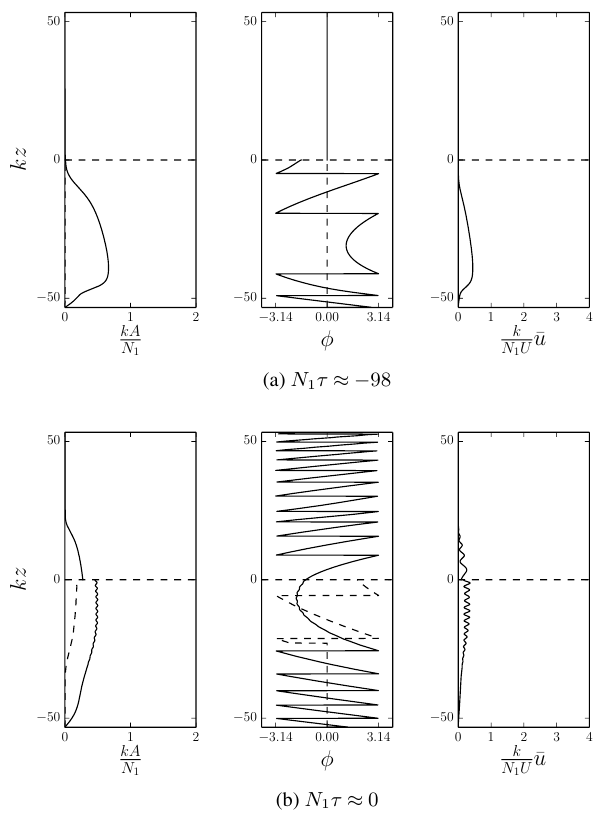
Figure 14. Vertical profiles of the wave magnitude A (left panel), phase φ (center panel), and mean flow (right panel) at three times in two layers. The parameter values are n 1 /k (cid:15) = 0.025, and α = 0.1. The line conventions are the same as Fig. 3.